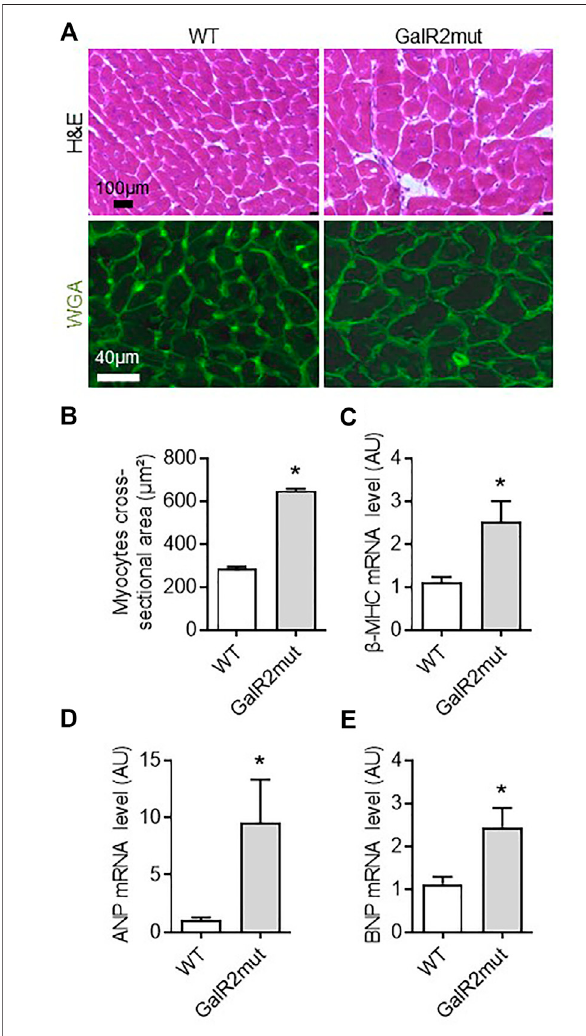
FIGURE 2 | Cardiac hypertrophic phenotype in GalR2 de fi cient mice. RepresentativeimagesofcardiacsectionsstainedwithH&EandWGA (A) and quanti fi cation of the cross-sectional area of cardiomyocytes from A in WT and GalR2mut mice (B) , n = 5 – 6 mice. Myocardial mRNA levels of the hypertrophic markers ( β -MHC, ANP, and BNP) in WT and GalR2-Mut mice (C – E) , n = 7 – 9 mice. Data are presented as the mean ± SEM, * p < 0.05 vs. WT.